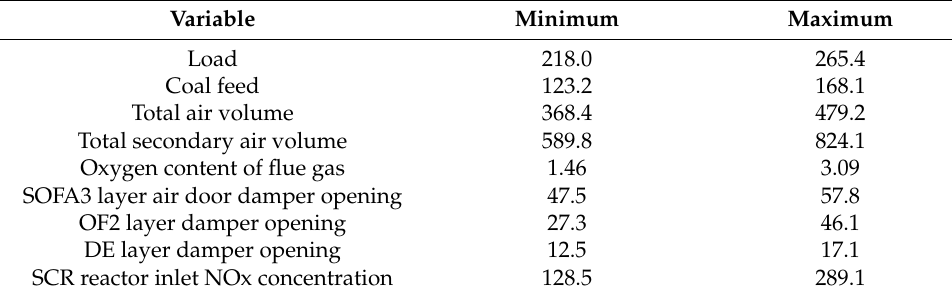
Table 1. Part of the input and output variables of the